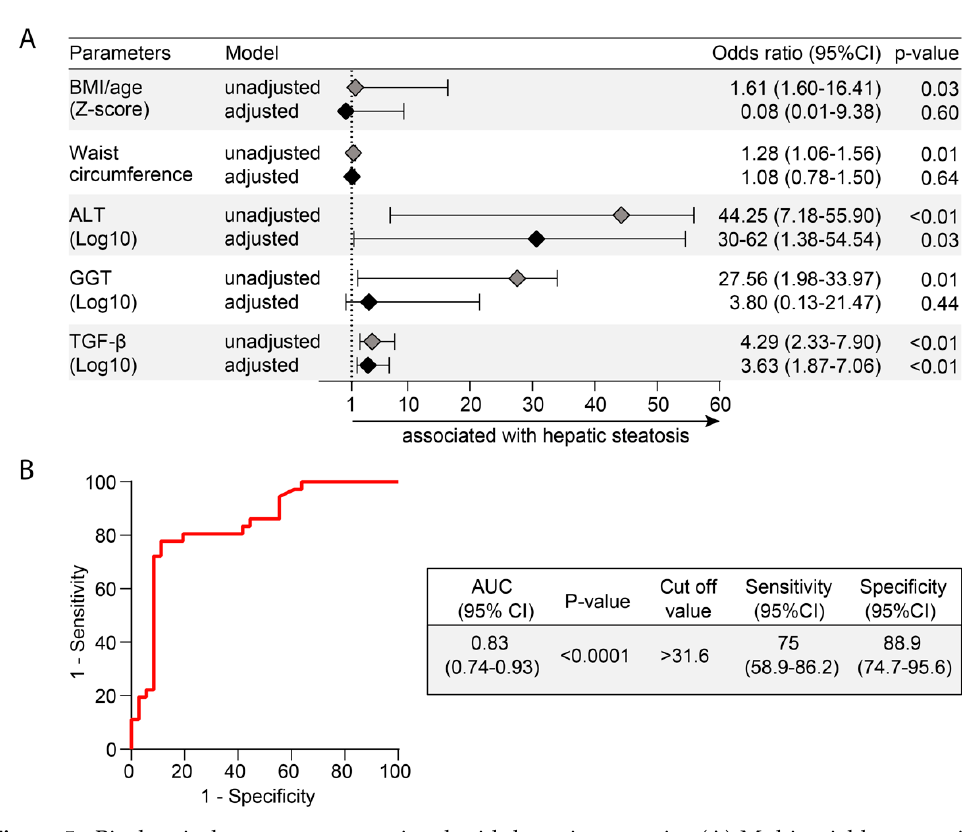
Figure 5. Biochemical parameters associated with hepatic steatosis. ( A ) Multivariable regression model of variables that were statistically significant ( p < 0.05) in univariate comparisons (see univariate comparisons in Tables S1 and S2). ( B ) Receiver Operator Characteristic (ROC) curves were employed to test the performance of TGF- β to distinguish patients with or without hepatic steatosis.